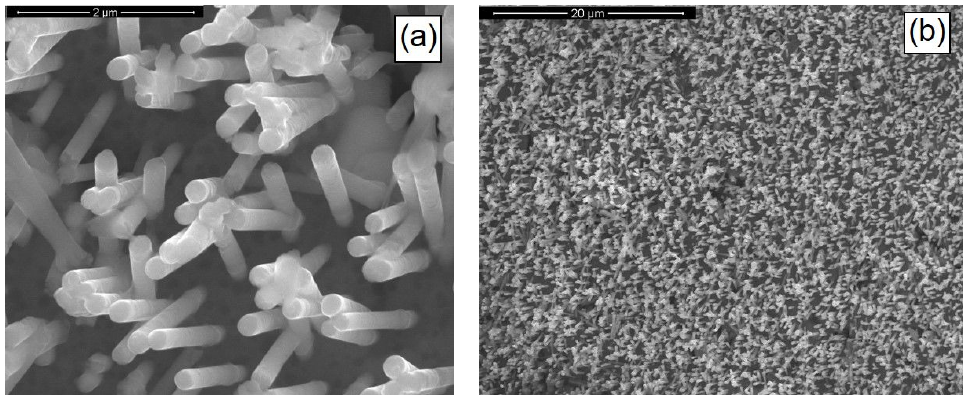
Figure 4. SEM images of CZTSe NWs. ( a ) High and ( b ) low magnification. The NWs were obtained at pH = 3 with a copper content of 1 mM.